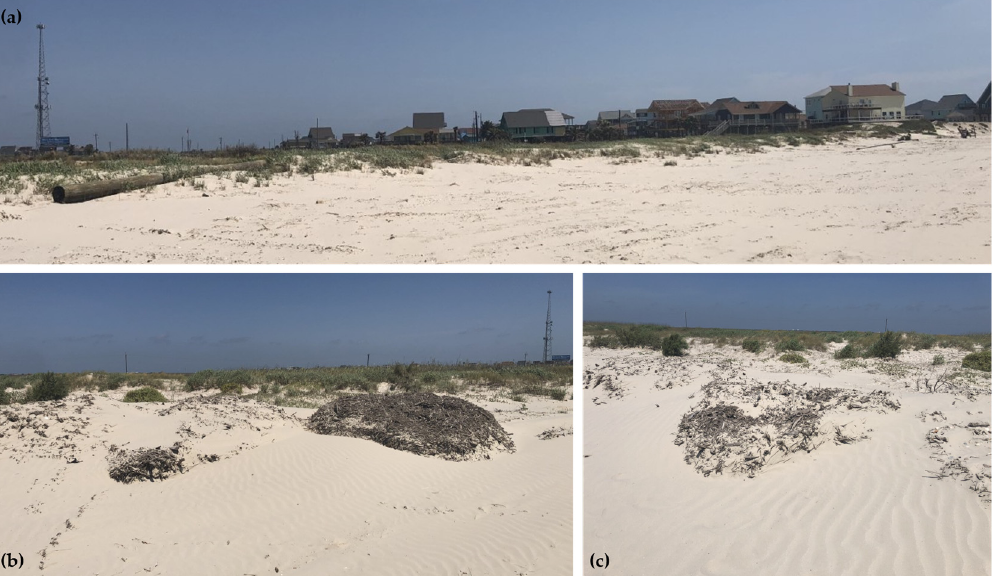
Figure 3. Follett’s Site 2 in May of 2022. ( a ) The UAV survey site with a flat backbeach followed by vegetated dune fields with no wood or mulch; ( b ) piles of wood chips at the westward end of the UAV survey; ( c ) example of a more eroded mulch pile compared to ( b ).